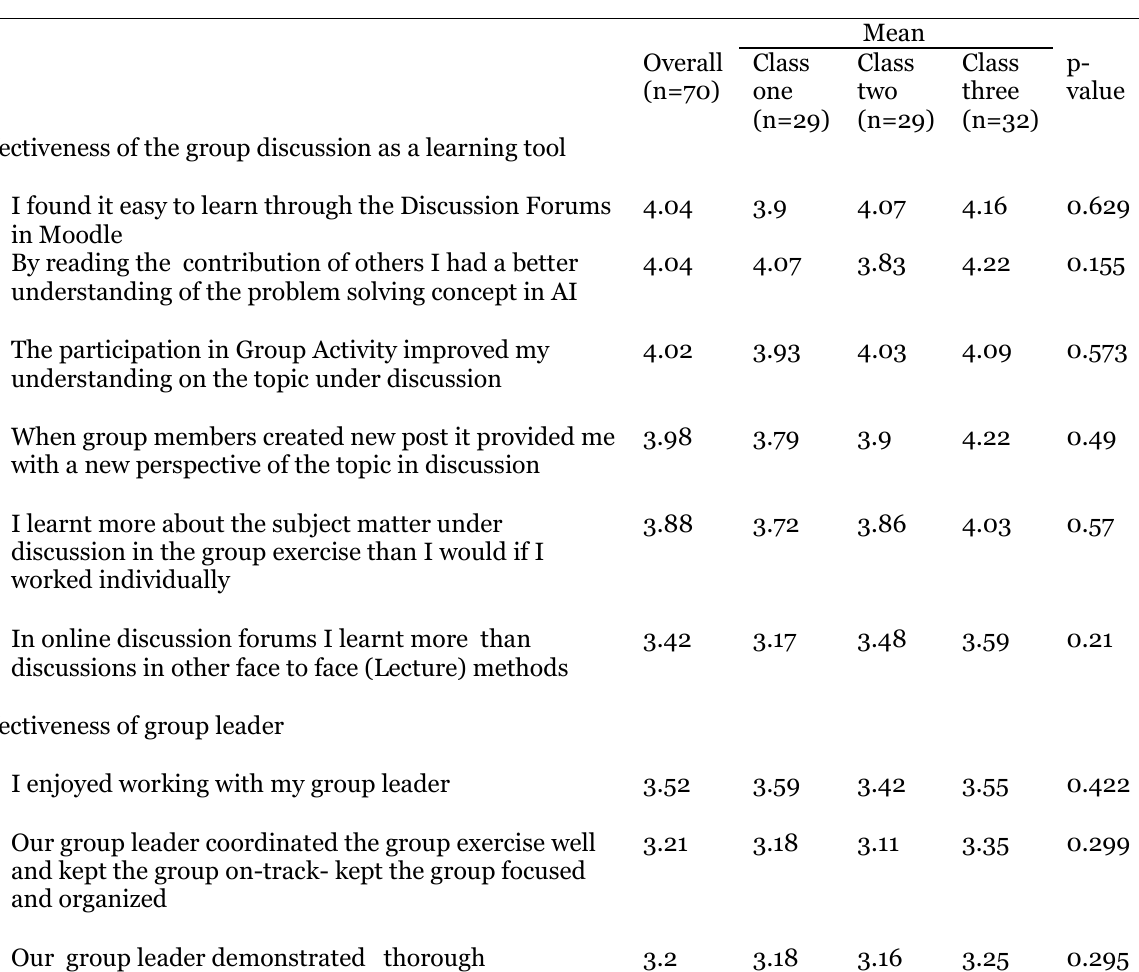
Group Outcomes Mean